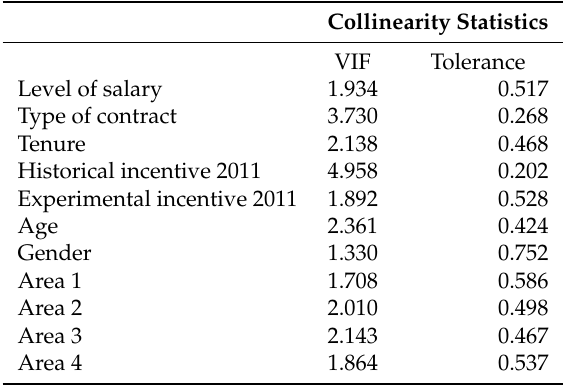
Table 8. Variance Inflation Factor (VIF) and Tolerance of the independent variables of the linear regression model described in Equation (6).